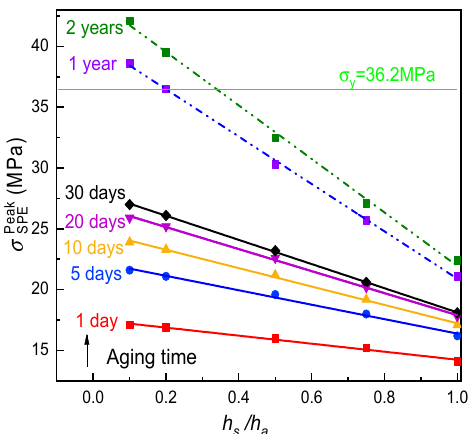
Figure 9. E ff ect of thickness ratio ( h s / h a ) on the peak tensile stress of SPE at various aging h h ) on the peak tensile stress of SPE at various aging times. Figure 9. Effect of thickness ratio ( s a